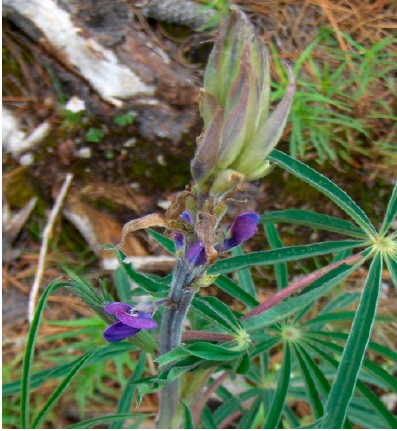
Figure 10. Lupinus montanus Kunth ssp. montanus. Photo: J. Ruiz.